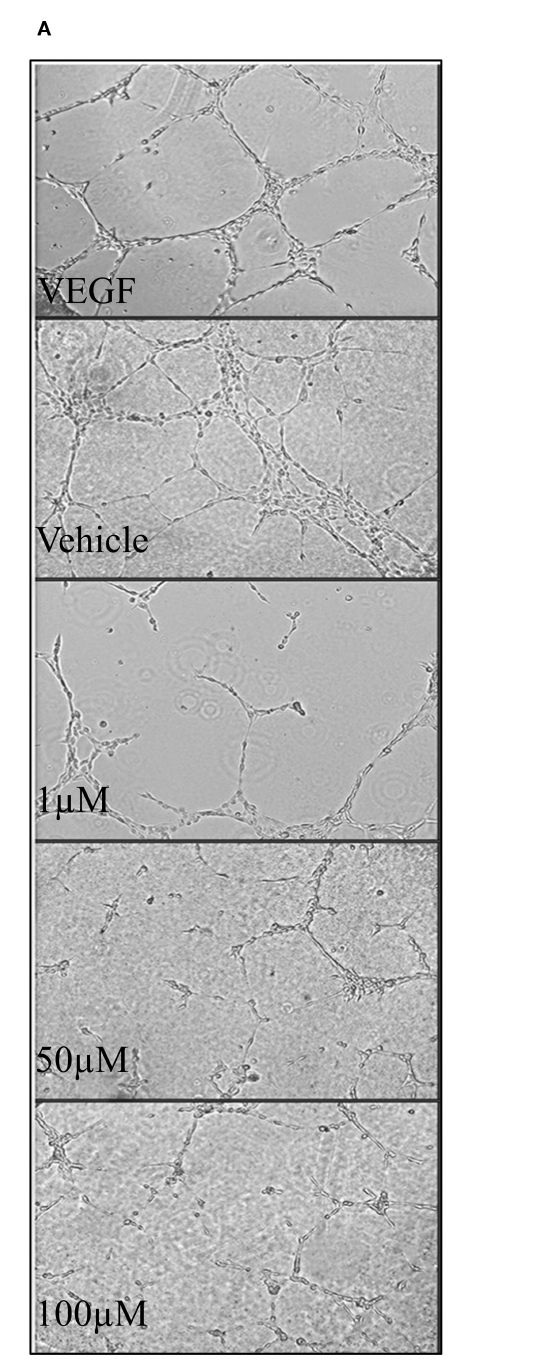
following: T cells (CD3), myeloid cells (CD11b), B cells (CD19), granulocytes (Ly6C and Ly6G), and macrophages/eosinophils (F4/80) ( Supplementary Figures 4A–F ). In summary, we show